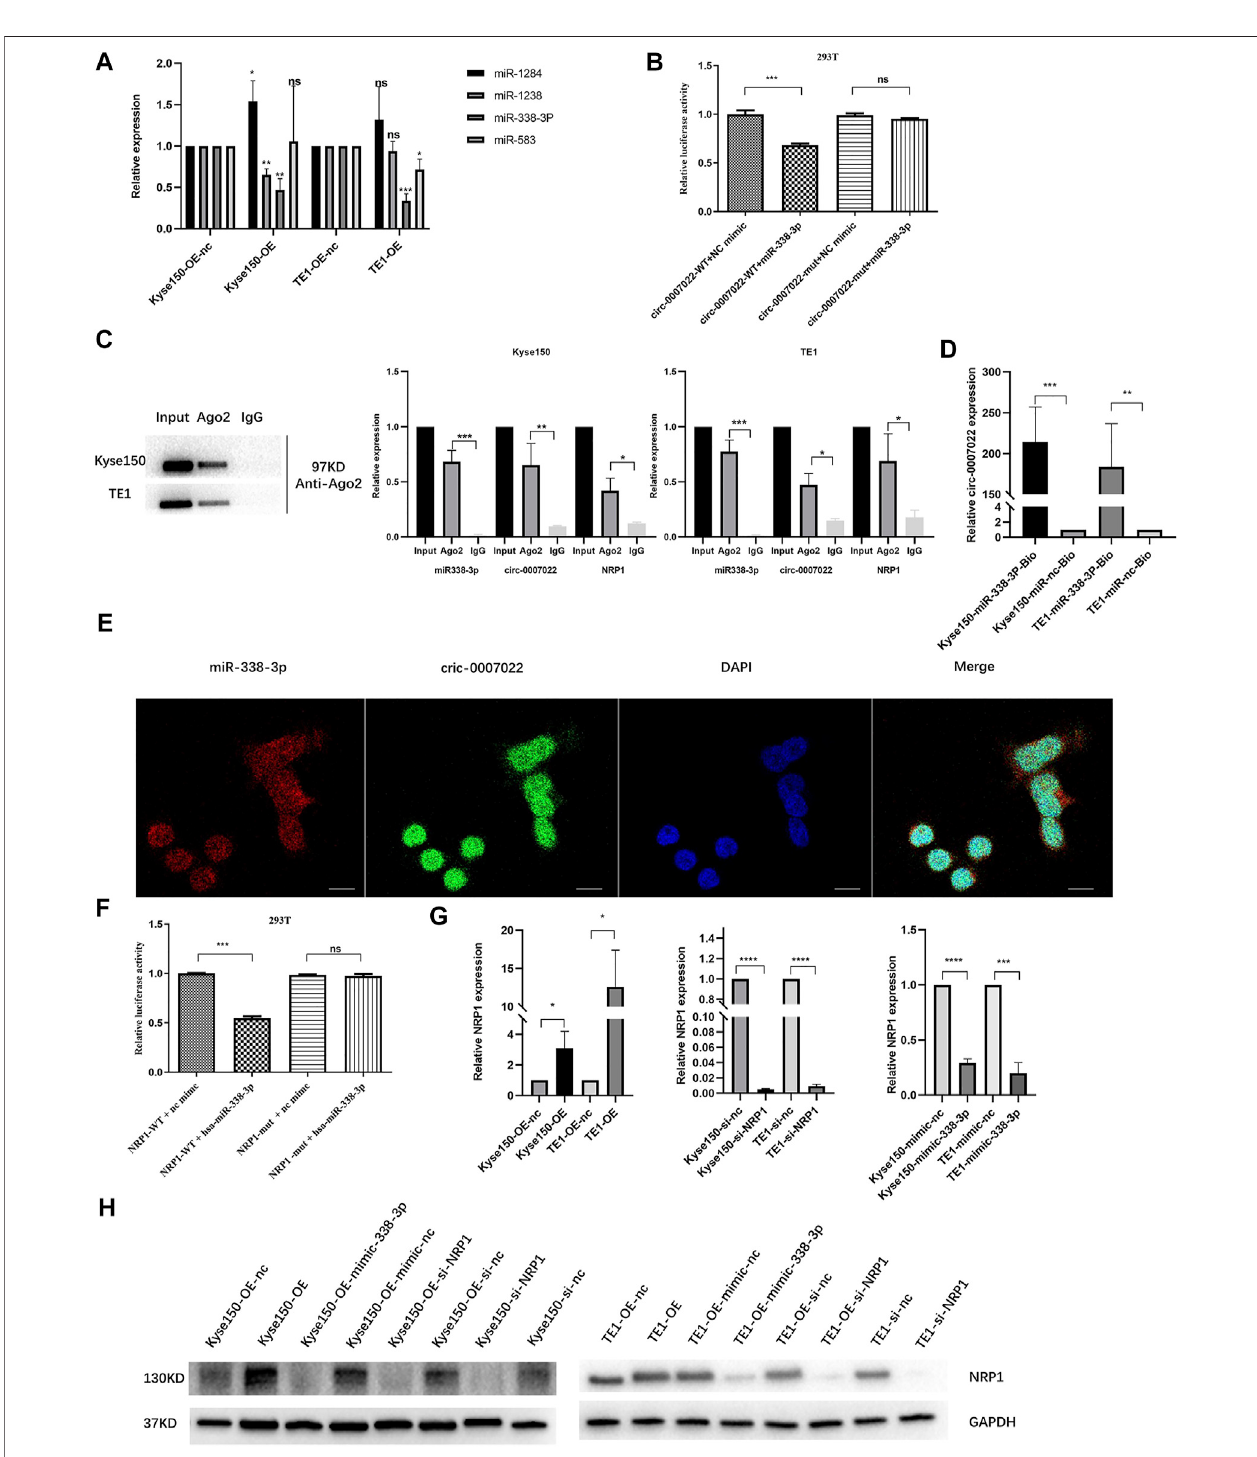
FIGURE 4 | Circ-0007022 functions as a sponge for miR-338-3p, and NRP1 is a direct target of miR-338-3p. (A) The qRT-PCR detected relative expression of candidatemiRNAsinKyse150andTE1cellstransfectedwithcirc-0007022overexpressionorknockdownplasmids. (B) Thedualluciferasereporterassayindicatedthat miR-338-3p mimics signi fi cantly decreased the luciferase activity of the circ-0007022-WT construct. (C) RNA Immunoprecipitation (RIP) analyzed the relationship betweencirc-0007022andmiR-338-3p,miR-338-3pandNRP1. (D) RNApulldownassaysanalyzedtherelationshipbetweencirc-0007022andmiR-338-3p. (E) FISH images shown locations of circ-0007022 and miR-338-3p in Kyse150 cells (Red, miR-338-3p probe; Green, circ-0007022 probe; Blue, DAPI nuclear staining; Scale bar 20 μ m). (F) Luciferase reporter assay con fi rmed the relationship between miR-338-3p and NRP1. (G,H) The qRT-PCR and Western blot revealed NRP1 expression inKyse150andTE1cellsaftercirc-0007022overexpression,miR-338-3p overexpressionorNRP1 knockingdown.Dataareexpressed asmean±SD,ns > 0.05, * p < 0.05, ** p < 0.01, *** p < 0.001, **** p < 0.0001.